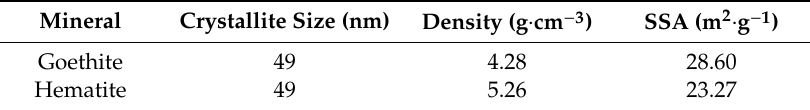
Table 2. The specific surface area of goethite and